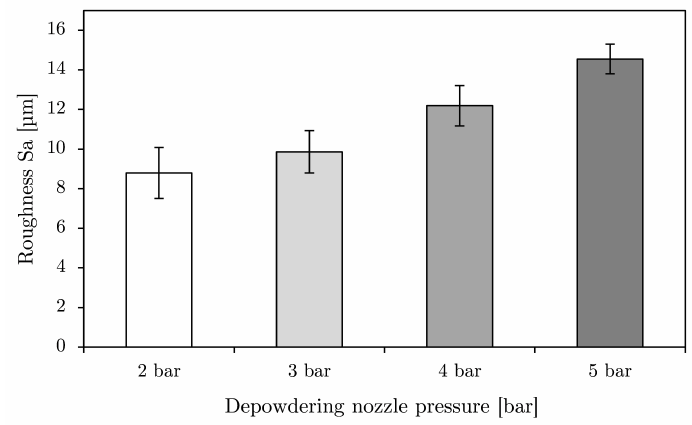
Figure 11. Surface characteristics for different depowdering air